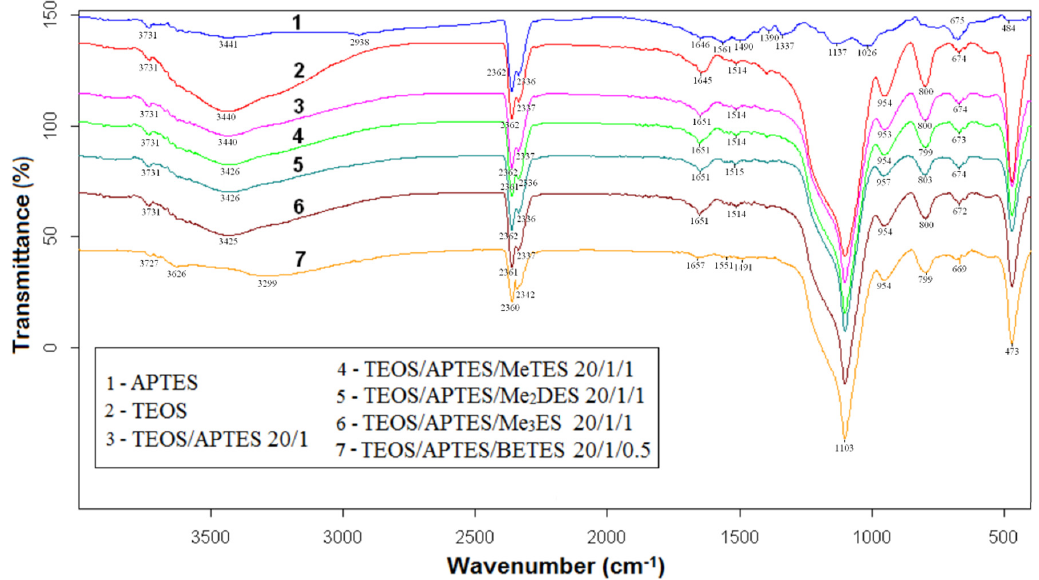
Figure 5. FTIR spectra of aminopropyl functionalized silica particles.